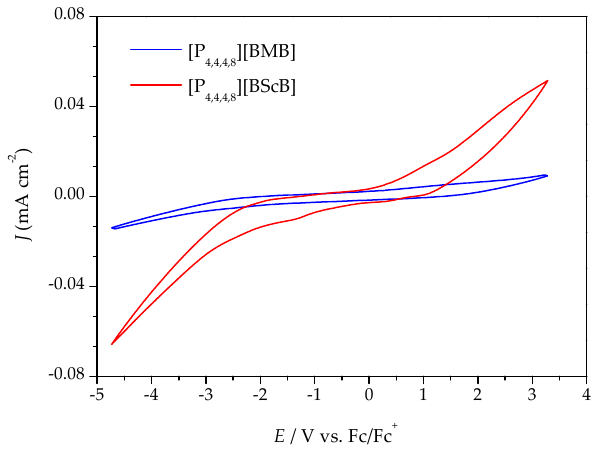
Figure 4. Cyclic voltammograms of the ILs at a GC electrode at 20 °C and a 100 mV s −1 potential sweep rate.